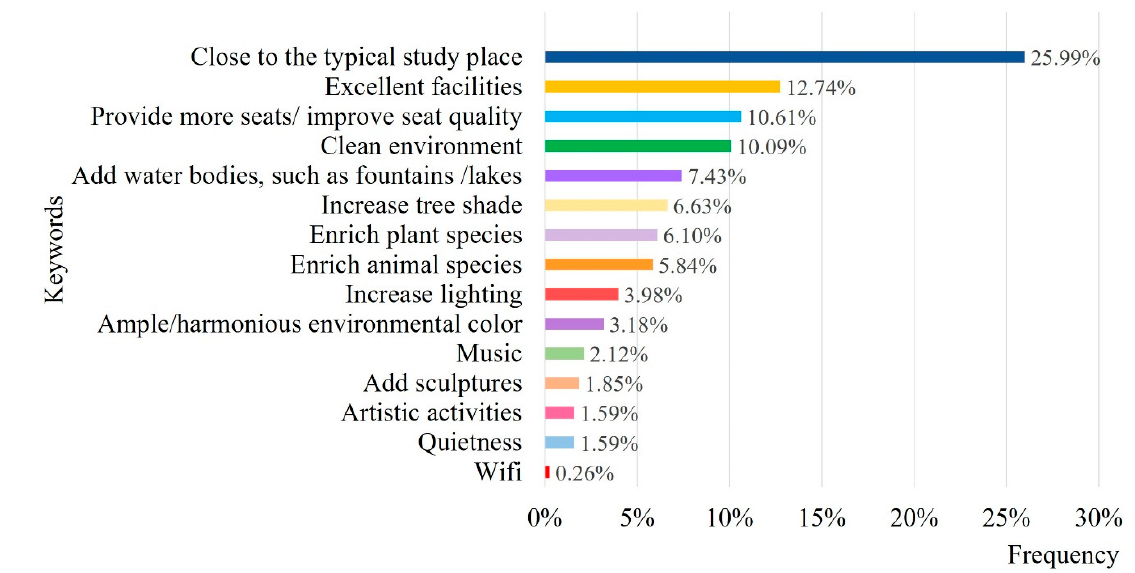
Figure 10. Keyword frequency of ideal attention restoration space on campus.